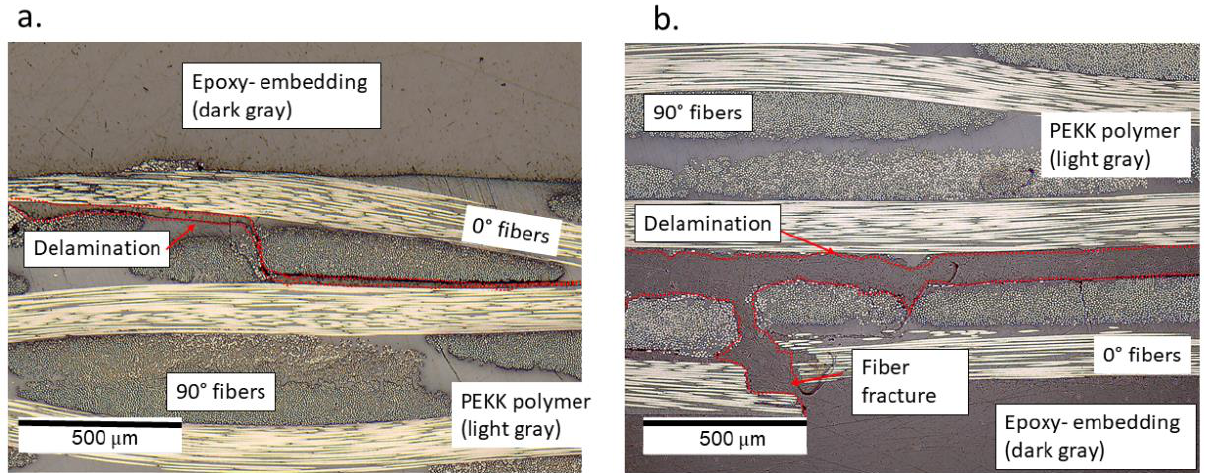
Figure 12. The delamination observed ( a ) in the top layer and ( b ) in the bottom layer of the specimen tested at a cyclic amplitude of 50 μ m and a pause time of 2 s.